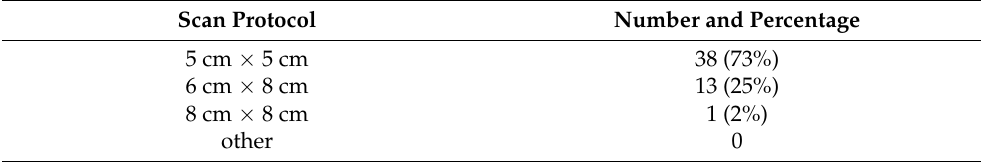
Table 1. Table showing the scan protocols used for the 52 patients included in the service evaluation.